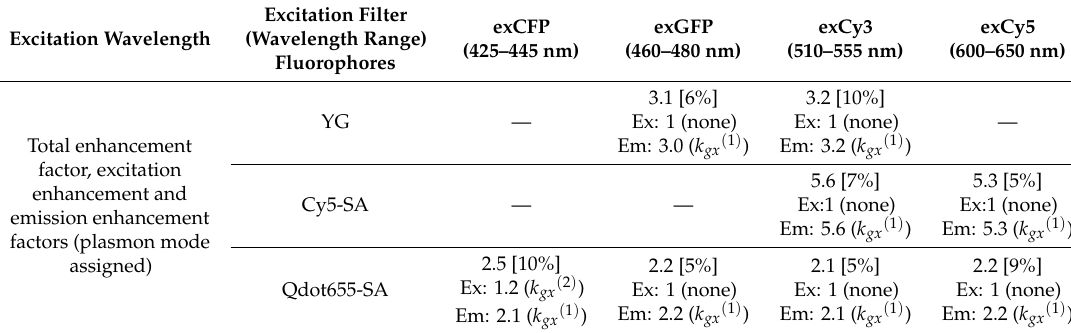
Table 8. Fluorescence enhancement factors of the fluorophores with emCy5 for the 1D chip in